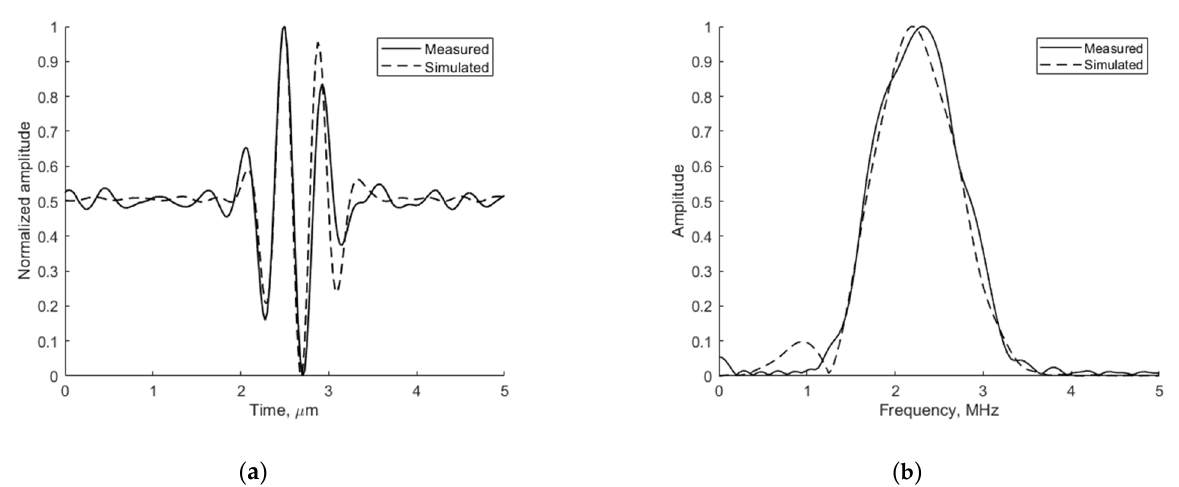
Figure 6. Comparison of measured physical and simulated digital ( a ) pulse-echo waves reflected from wire target (in Model 549) at 74 mm depth (axial view) and ( b ) their spectrum.